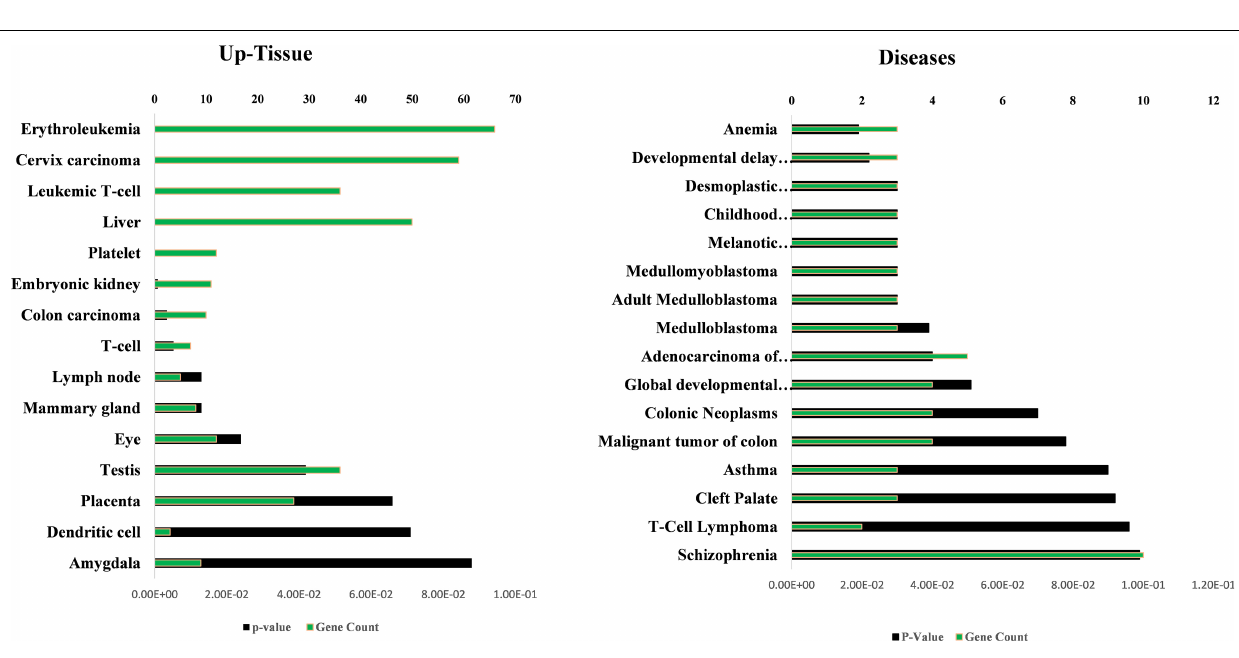
FIGURE 9 | Up-tissue expression and involvement in diseases of all the mutual DEGs (107) between SCD versus aMCI, aMCI versus control, and SCD versus control. The annotation terms are mentioned with a number of genes along with significance ( p